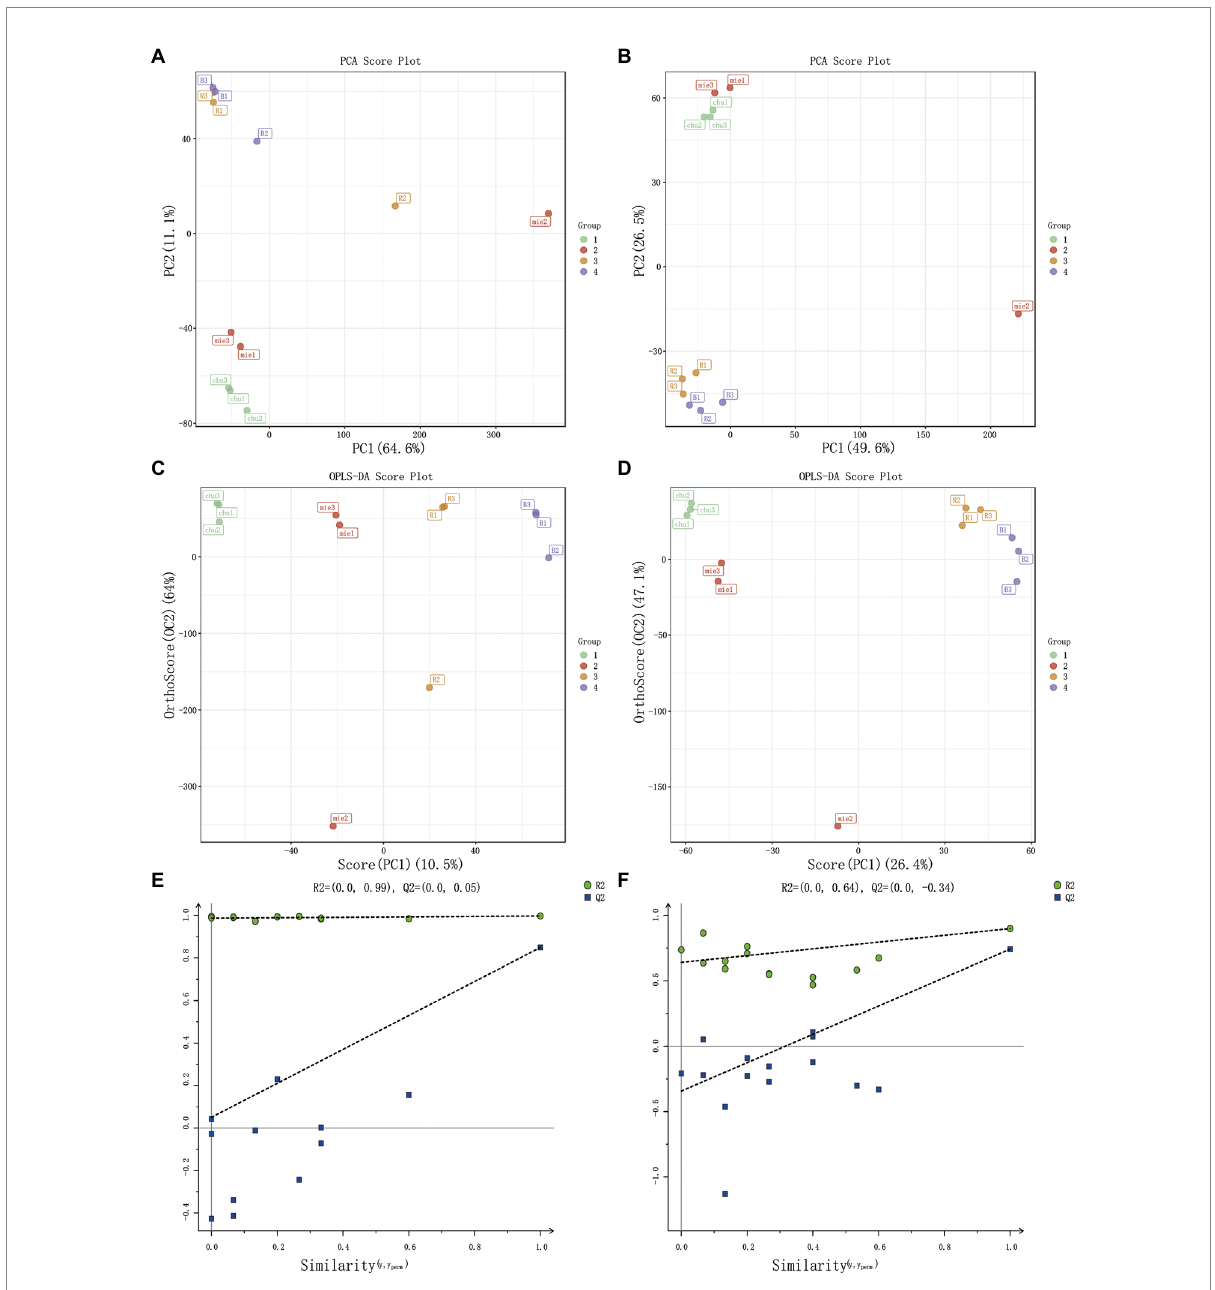
FIGURE 2 Multivariate statistical analysis of Poria cocos fermentation broth. PCA score plot (A) in positive EIS mode and (B) in negative EIS mode. OPLS-DA score plot (C) in positive EIS mode and (D) negative EIS mode. OPLS-DA displacement test chart (E) in positive EIS mode and (F) in negative EIS